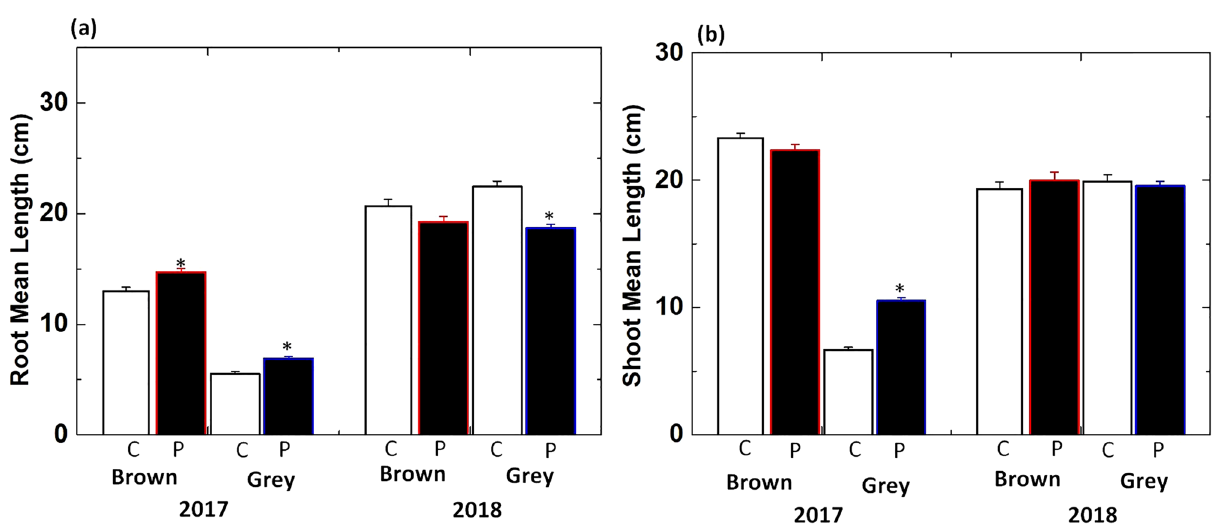
Figure 3. Average length of (a) roots and (b) shoots of sprouts germinated from control (C) and plasma treated (P) radish seeds harvested in 2017 and 2018 year. Results are presented as means ± SEM (n = 40).*Significantly different from the control group (p <